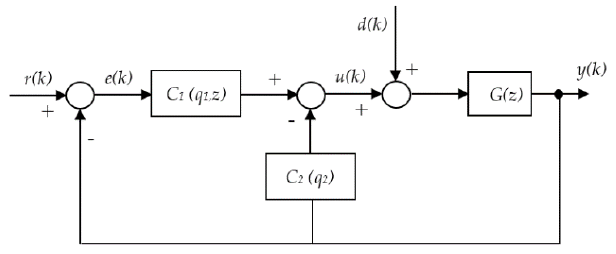
Figure 1. Closed ‐ loop of the feedback ‐ type (FB) ‐ type 2DOF (two ‐ degrees ‐ of ‐ freedom) PI ‐ P Figure 1. Closed-loop of the feedback-type (FB)-type 2DOF (two-degrees-of-freedom) PI-P (proportional ‐ integral/proportional) control system. (proportional-integral/proportional) control